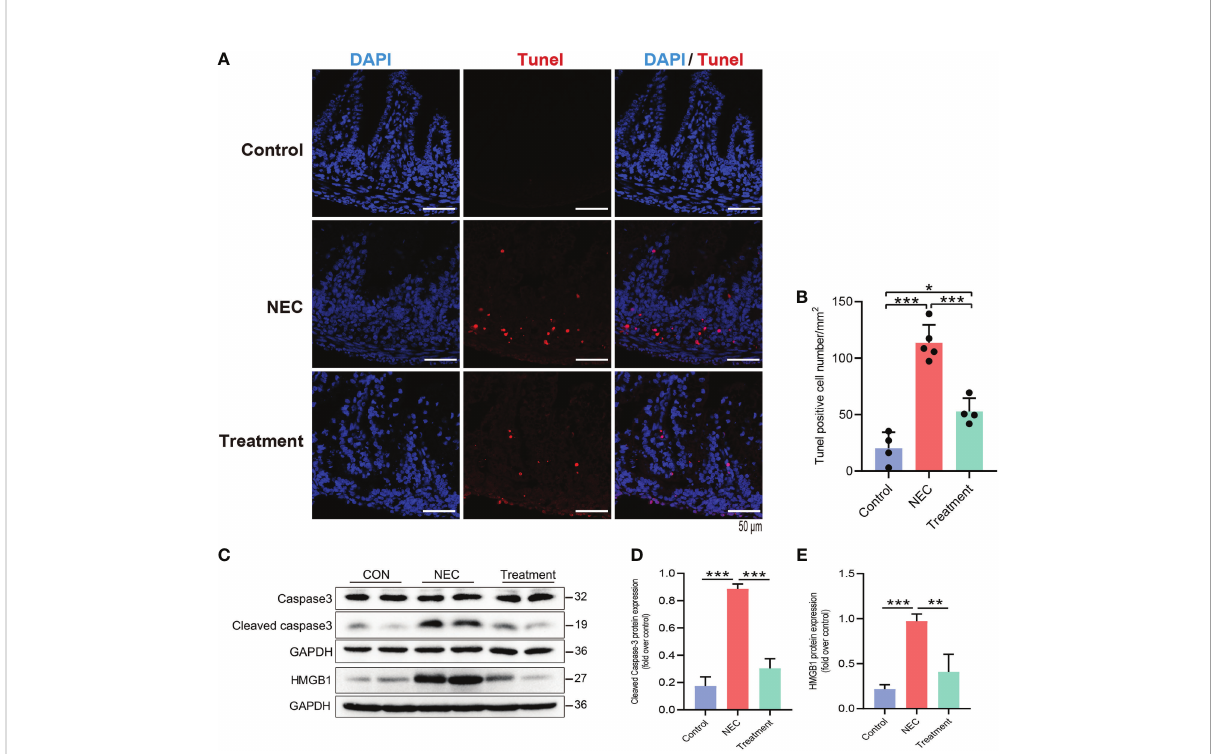
FIGURE 4 MD2 blockade attenuates apoptosis of intestinal epithelial cells in NEC rats. (A, B) Detection of intestinal cell apoptosis in each group of neonatal rats; red represents TUNEL + cells. NEC signi fi cantly increased TUNEL + cells, while pretreatment with MD2 inhibitor signi fi cantly blocked this effect (n=4 in the control group, n=4 in the treatment group and n=5 in the NEC group). Scale bar, 50 m m. (C – E) The protein expression of cleaved caspase-3 and HMGB1 in the intestines of the three groups was analyzed by Western blotting (n=3). The p value was analyzed by one-way ANOVA with multiple comparisons, followed by Tukey ’ s post hoc test. *p <0.05, **p <0.01, ***p